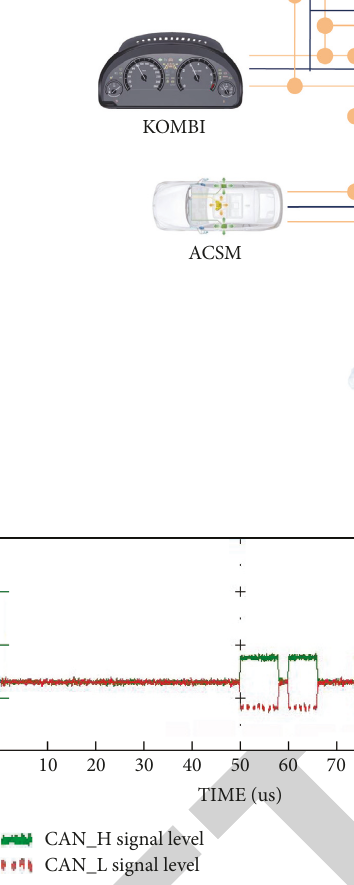
Figure 2: Signal waveform of PT-CAN under the conditions of normal data transmission.